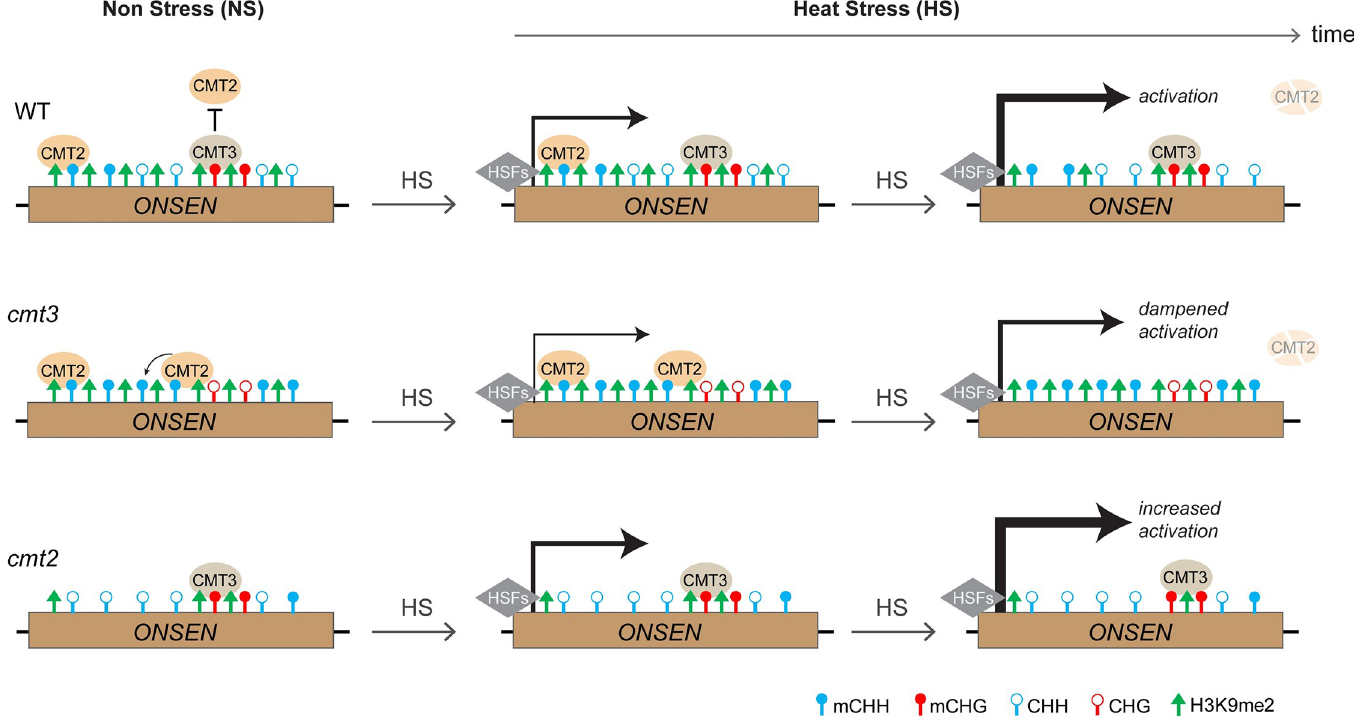
Fig 6. Working model for CMT3 function in heat-induced ONSEN activation. Under non-stress (NS) conditions, CMT2 and CMT3 are recruited to ONSEN locus by H3K9me2 via a self-reinforcing loop. In the wild-type (WT), CMT3 in the ONSEN region suppresses the binding of CMT2. Loss-of-function CMT3 induces increased CHH methylation mediated by CMT2. Upon heat stress (HS), ONSEN transcription is activated by heat shock factors (HSFs). The high levels of CHH methylation and H3K9me2 at ONSEN chromatin in cmt3 dampen its transcriptional activation by HSFs. In cmt2 , the CHH methylation and H3K9me2 levels are low, leading to increased ONSEN transcription under heat stress. CMT2 protein is degraded by prolonged heat